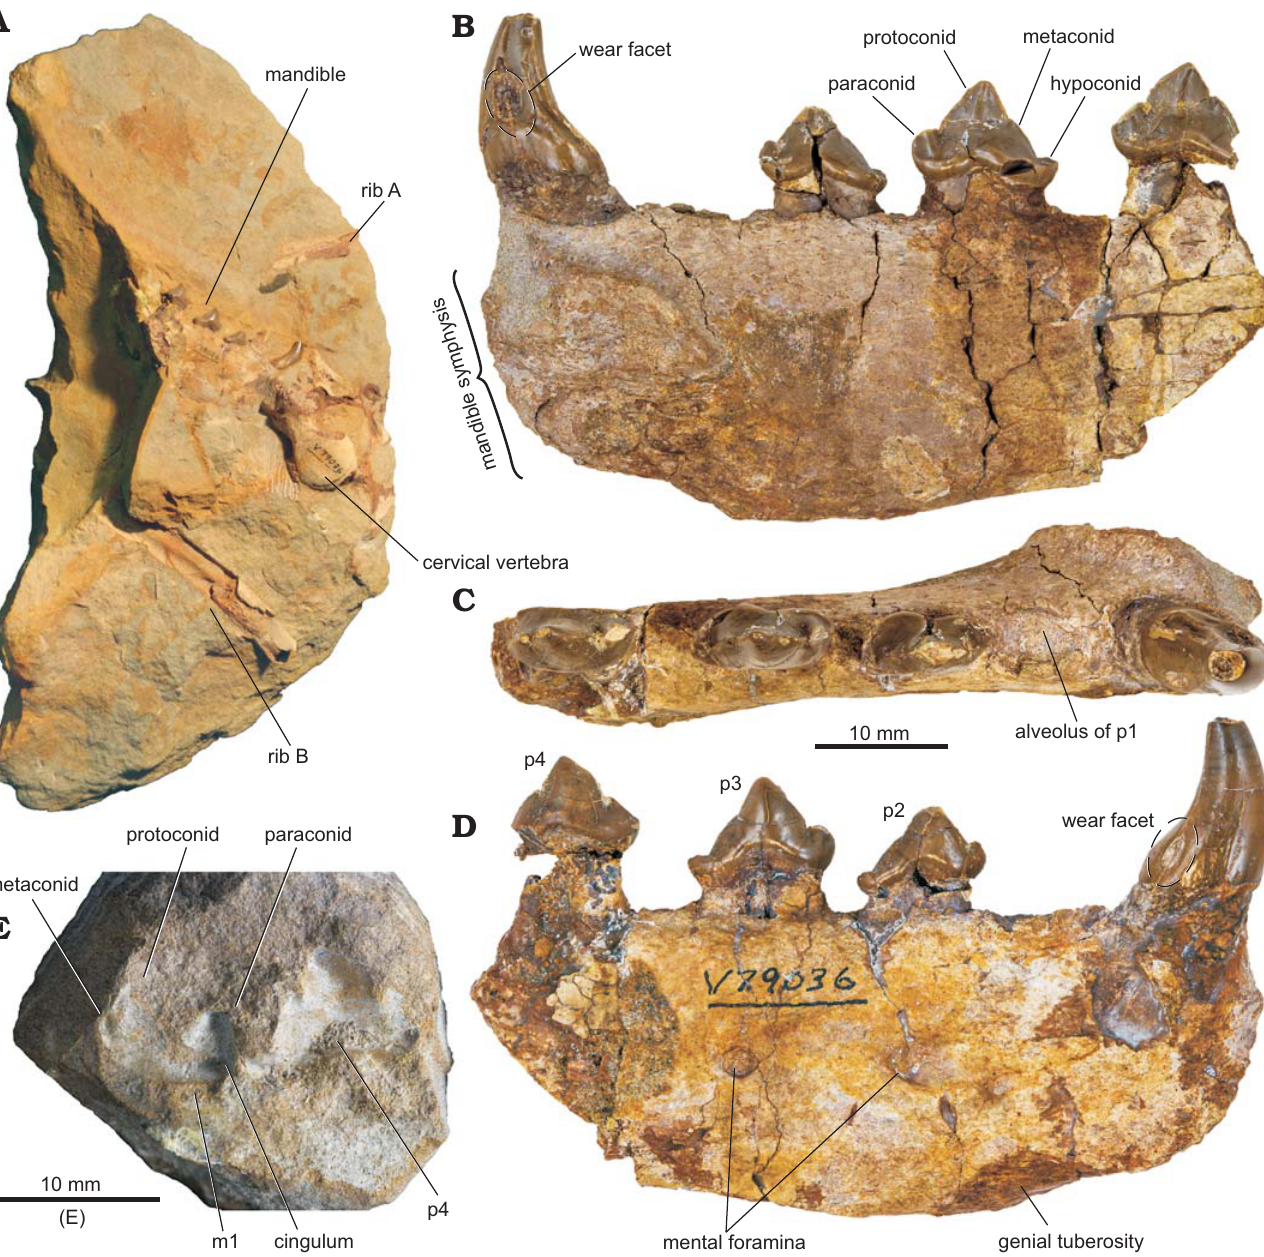
Fig. 5. Elements of pinniped mammal Enaliarctos sp., cf. E. tedfordi Berta, 1991 (UCMP 253400) from Ona Beach, Lincoln County, Oregon, Yaquina Formation, early late Oligocene; overview of original block ( A ), lingual ( B ), occlusal ( C ), and labial ( D ) views; matrix preserving impression of lingual side of p4 and m1 ( E